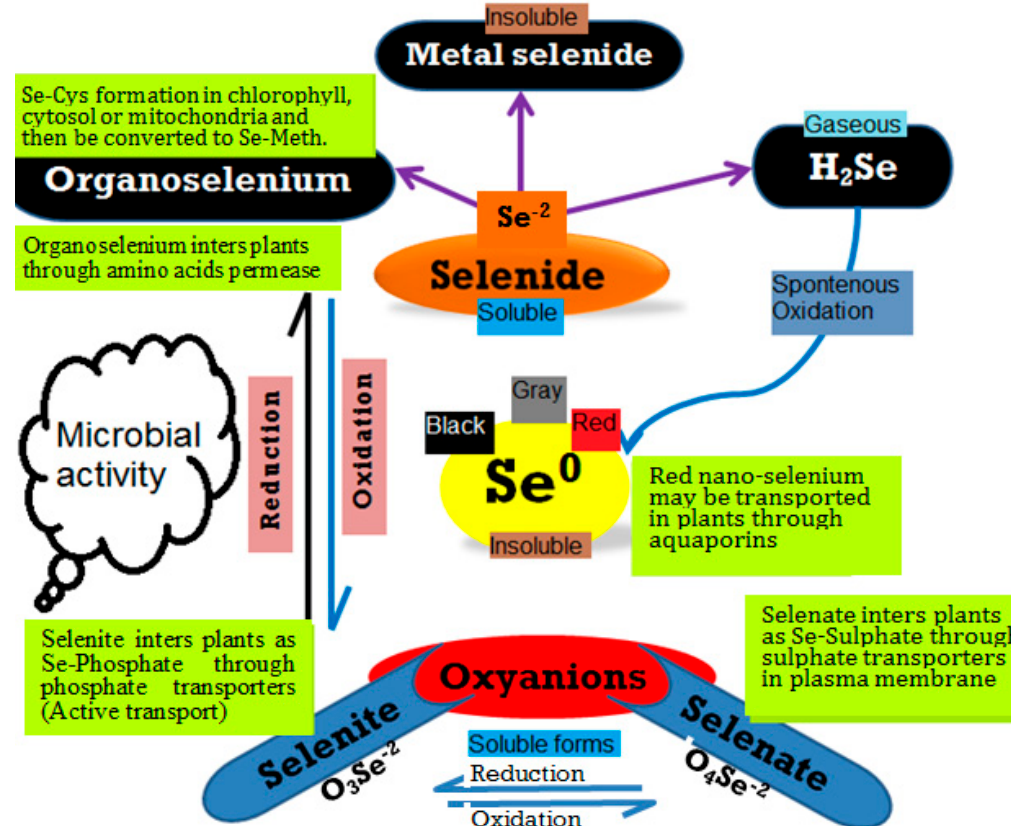
Figure 1. An overview of selenium and its transformations in the soil environment. Different pathways for the fate and transformation of Se and its forms in the environment can be distinguished, including selenate, selenite, and elemental nano-Se.